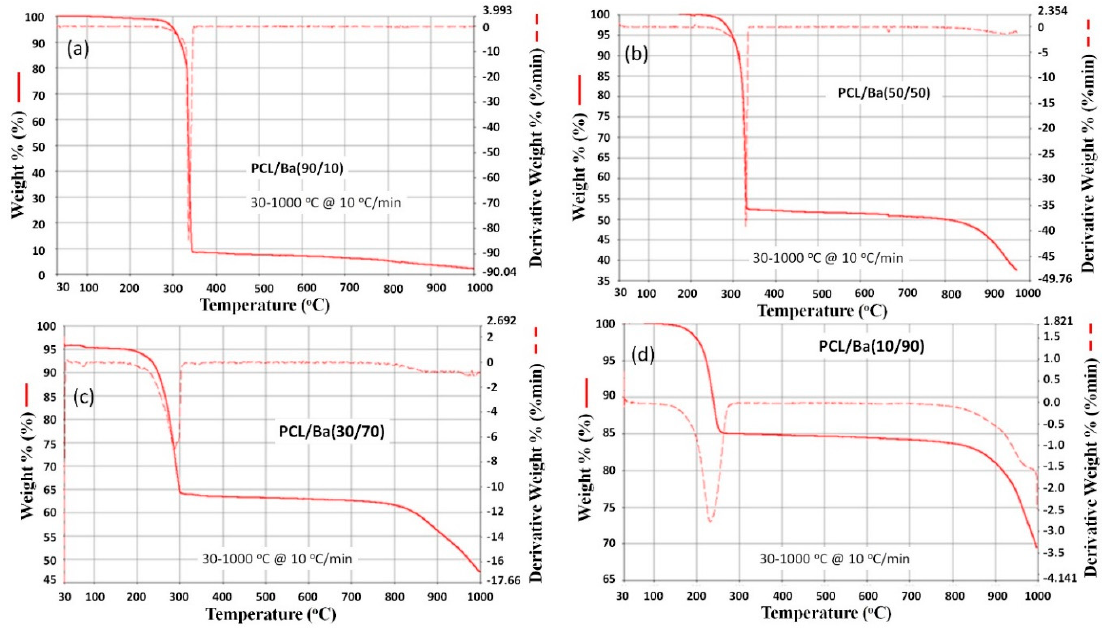
Figure 7. Thermograms of PCL/Ba composites: ( a ) 90/10, ( b ) 50/50, ( c ) 30/70, and ( d ) 10/90.